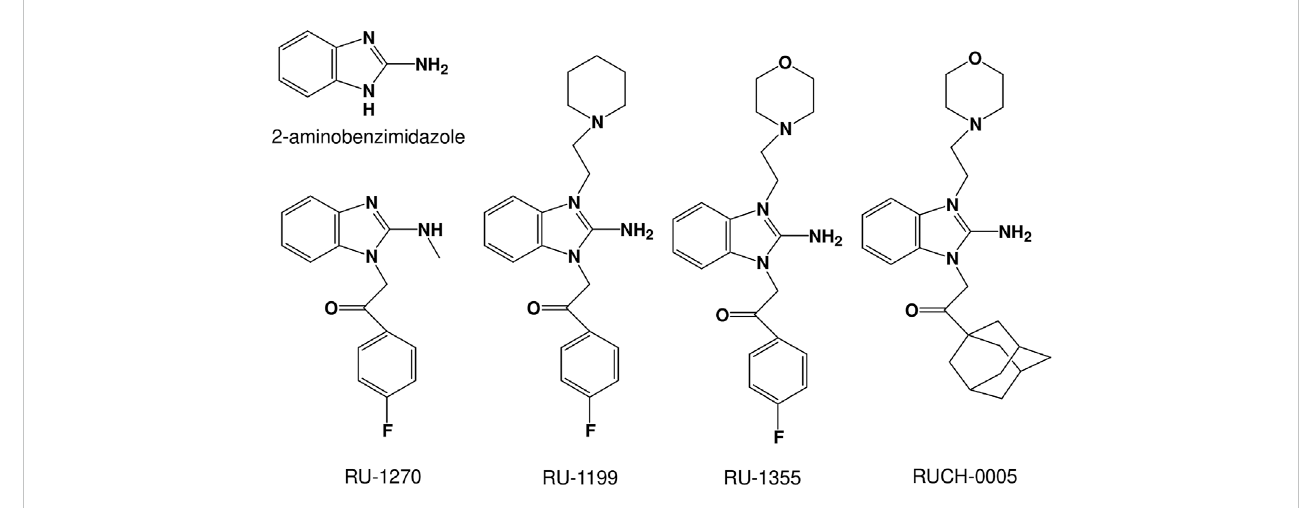
FIGURE 1 Chemical structures of the 2-aminobenzimidazole derivatives